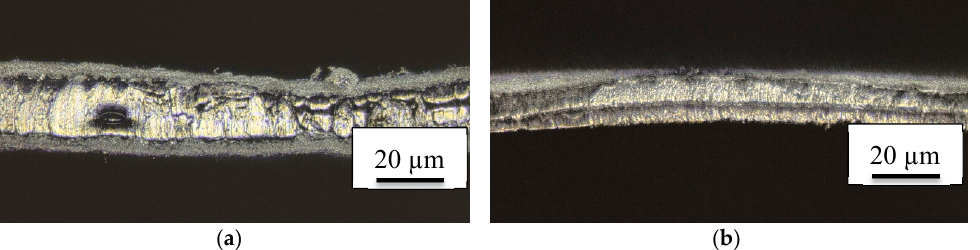
Figure 3. Nanofiber mats joined with textile glue: ( a ) Drying without pressure; ( b ) Drying under pressure.